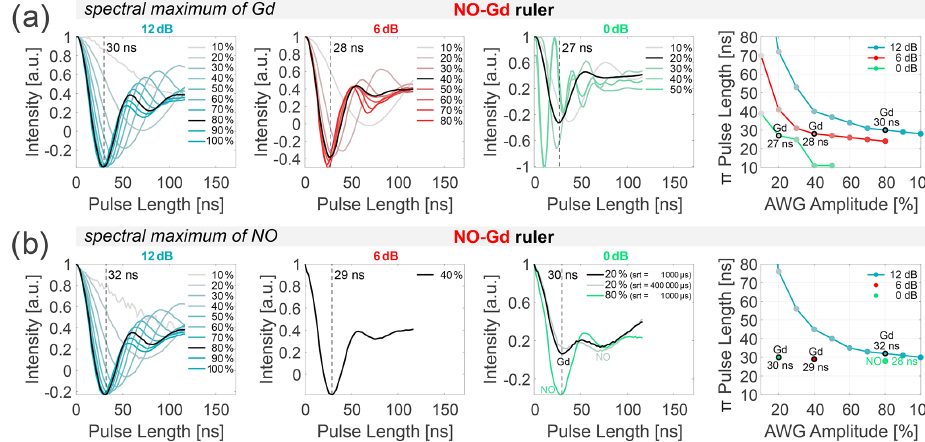
Figure 2. Power dependence of NO and Gd π pulses. Transient nutation experiments were performed at different spectral positions of the NO–Gd ruler at 10K. Data were recorded at 12, 6, and 0dB attenuation (columns 1 to 3), varying the arbitrary waveform generator (AWG) amplitude. The fourth column shows the correlation of the extracted π pulse lengths (first minimum of the nutation transient) and the AWG pulse amplitude (in percent) for the different main attenuator settings (in decibels). All extracted π pulse lengths are given in Table S2 (part B). The transients shown in (a) were recorded on the spectral maximum of the Gd, and those in (b) were recorded on the maximum of the NO spectrum, which is 10.4mT lower in magnetic field than the maximum of the Gd for the utilized sample (see Fig. 3) using a shot repetition time (srt) of 1000µs (if not stated differently). (a) In our setup, 12dB attenuation and 80% AWG amplitude correspond to a 30ns Gaussian π pulse on Gd. Doubling the power (6dB) always requires halving the AWG amplitude to keep the same π pulse length (highlighted in black for a ≈ 30ns π pulse). (b) A srt of 1000µs makes the nutation experiments more sensitive to Gd at 10K (see relaxation data given in Figs. S1 to S3 and Table S3 to S4; part B). At 0dB main attenuation and 20%AWG amplitude, the nutation of the NO also becomes visible (black). Prolonging the srt to 400000µs at 20% amplitude slightly increases the amplitude of the NO nutation with respect to the nutation of Gd (gray). A pulse amplitude of 80% also gives 30ns π pulse length (green), which corresponds to a π pulse on the NO